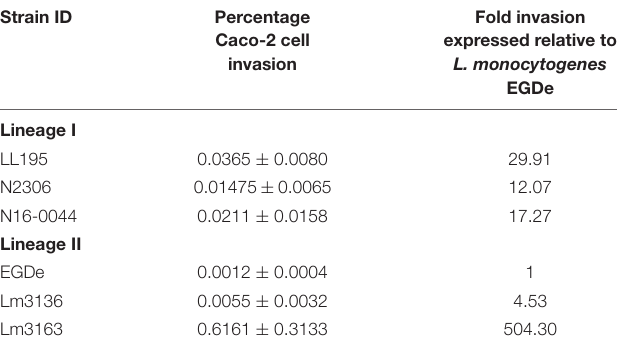
TABLE 5 | Comparison of Caco-2 cell invasion